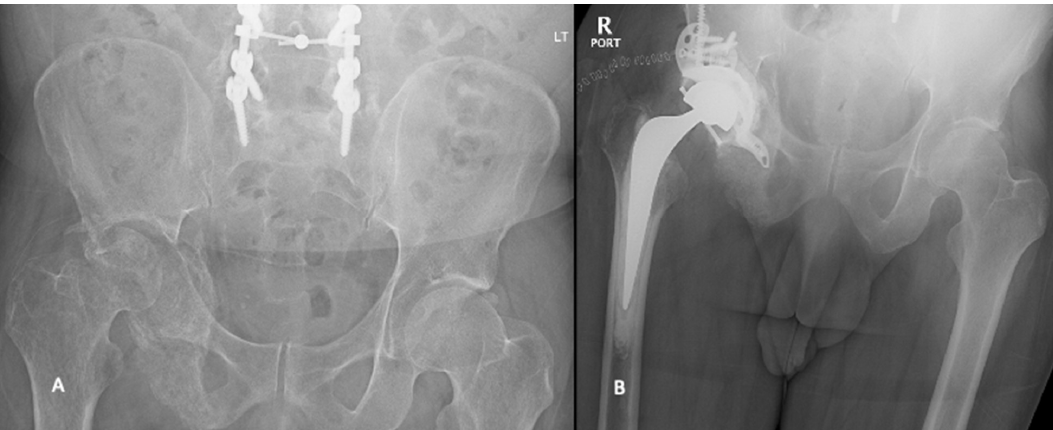
Figure 5. Pre- ( A ) and postoperative ( B ) radiographs of patient with metastatic small cell lung cancer who underwent cemented total hip arthroplasty with cage construct.